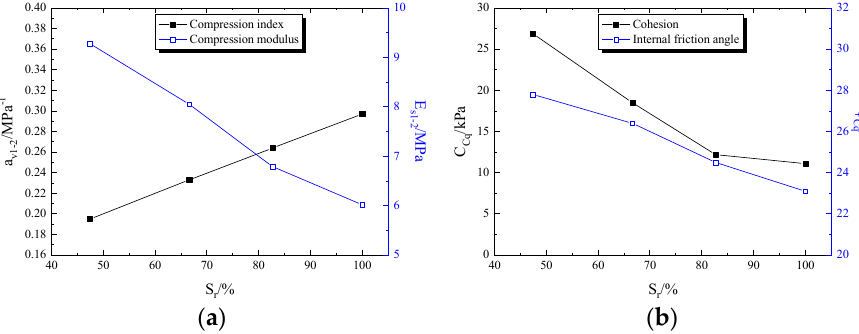
Figure 3. Variation curve of LTC2 − 4 sample: ( a ) compression index with saturation; ( b ) consolidation quick shear index with saturation.